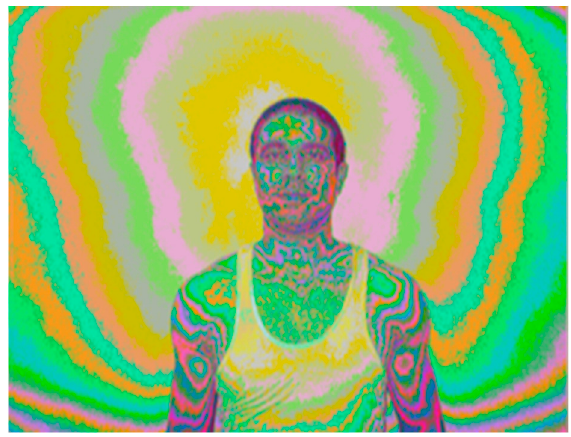
Figure 16. Aura visualization after the therapy.